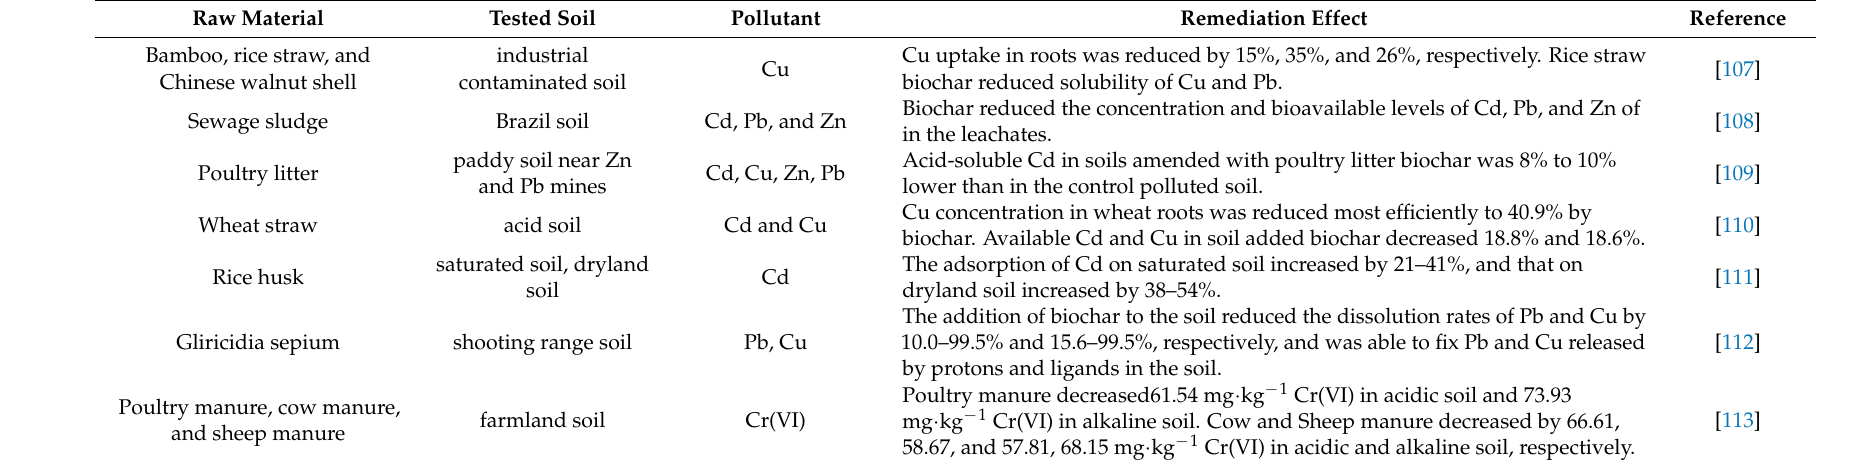
Table 4. Study on the application of biochar to the remediation of heavy metal pollution in